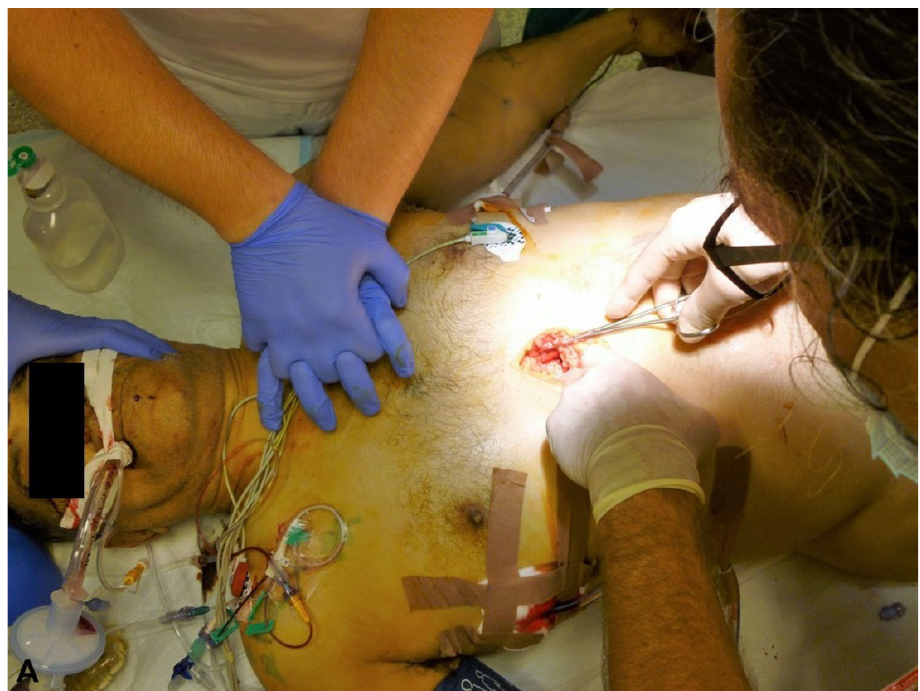
Fig. 2. Drainage of the pericardium via subxiphoid